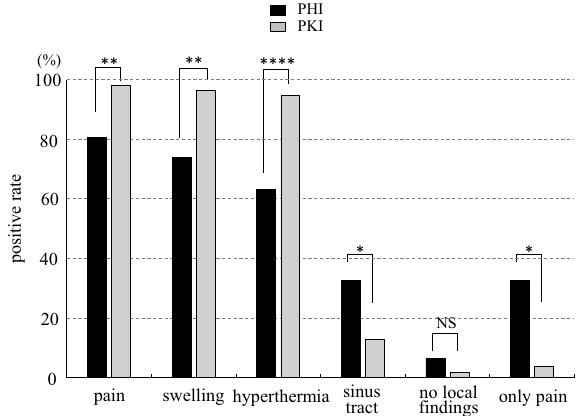
Figure 1. Positive rates of local findings in periprosthetic hip infection (PHI) and periprosthetic knee infection (PKI). The positive rates of pain, swelling, and hyperthermia in PHI were significantly lower than PKI. Only sinus tract in PHI was significantly higher than PKI. The frequency of no local findings was not significant difference between the groups. PHI showed a significantly higher frequency in the presence of pain as the only symptom compared to PKI. ****p < 0.0001, **p < 0.01, *p < 0.05, NS no significant difference.